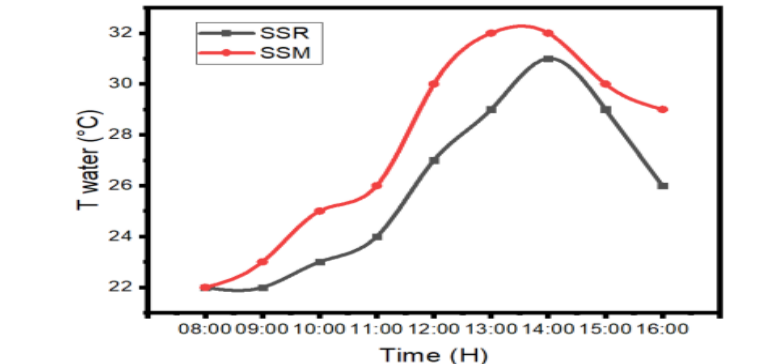
Figure 5. Water temperature